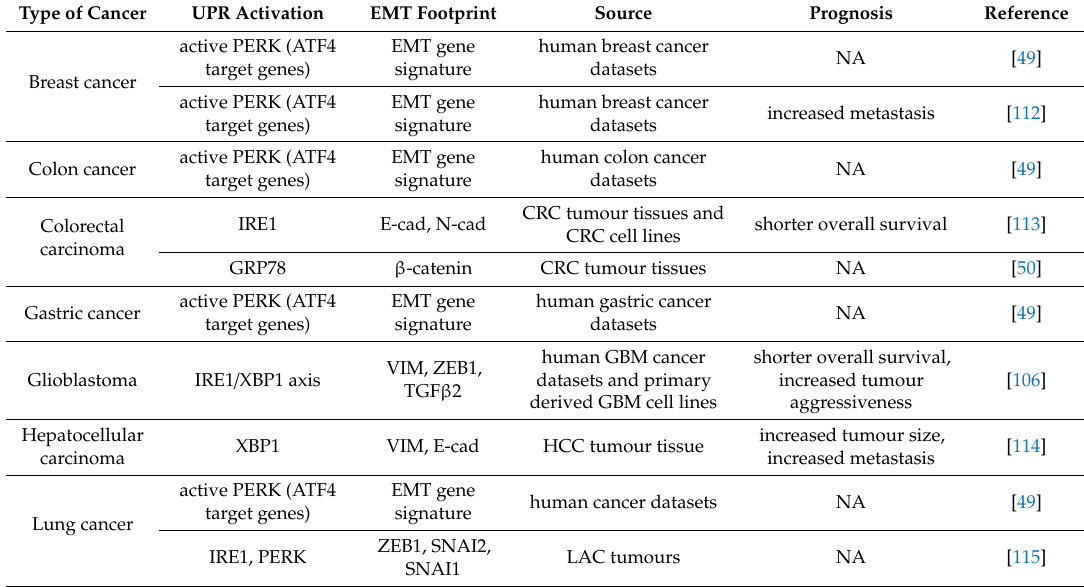
Table 1. Studies analysing UPR and EMT in clinical samples and / or primary derived cell